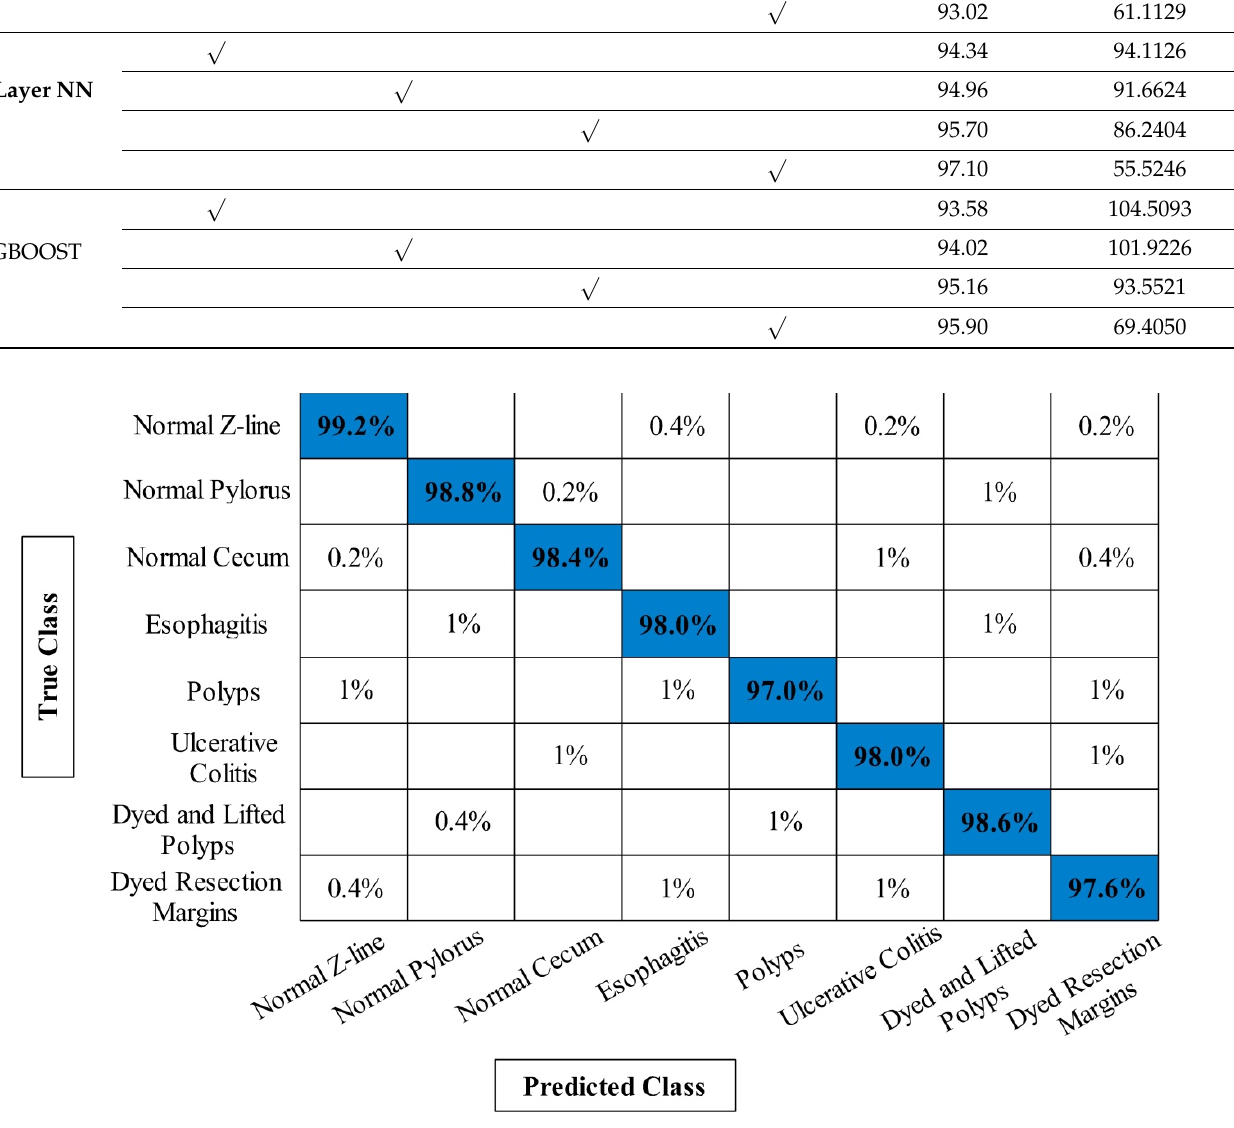
Figure 9. Confusion matrix of proposed framework for ELM classifier on Kvasir V1 dataset.